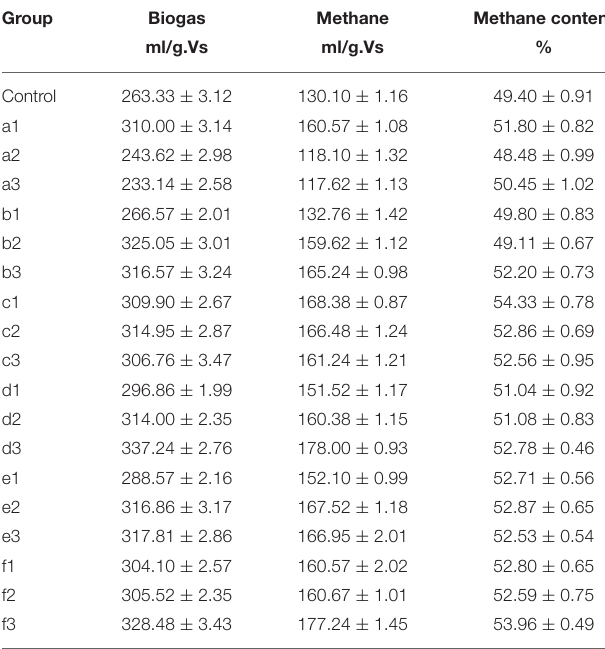
TABLE 2 | Cumulative production of biogas and methane is affected by the addition of different ratios of